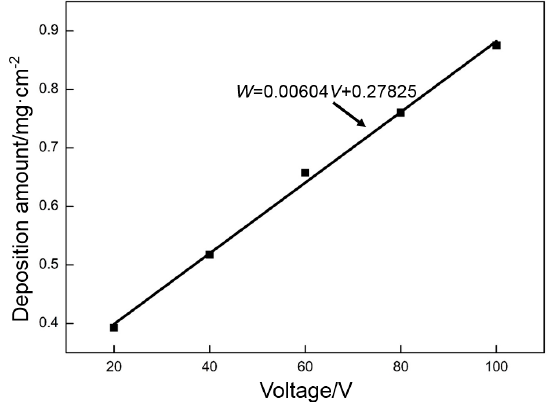
Figure 2. Relationship between voltage and deposition amount.